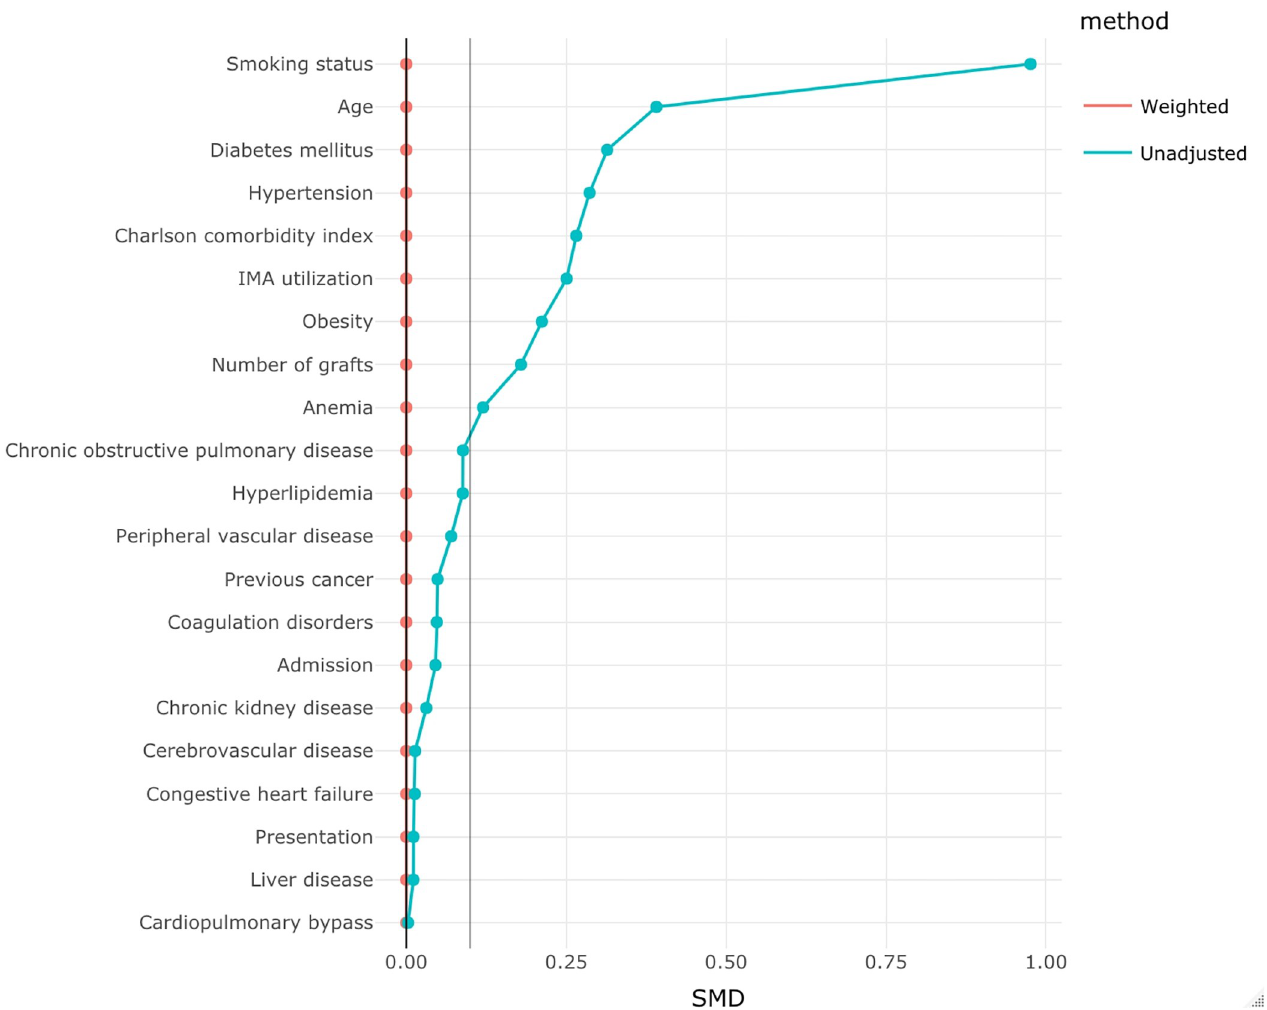
Fig 3. Covariate balance. Covariate balance: unweighted vs overlap weighted cohorts.